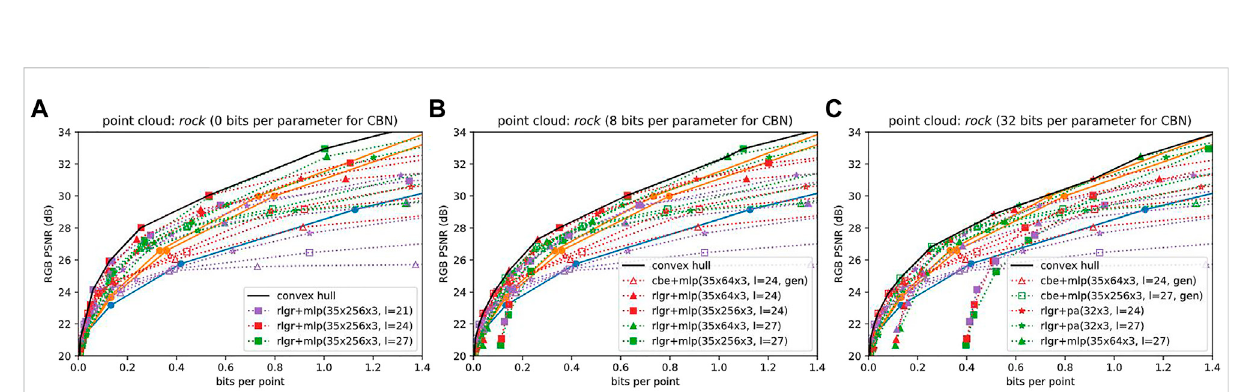
FIGURE 12 Convex hull (solid black line) of RD performances of all CBN con fi gurations across all levels, including side information using 0 (A) , 8 (B) , and 32 (C) bits per CBN parameter. Con fi gurations that participate in the convex hull are listed, with baselines, in the legend and appear as solid lines. Others are dotted. At 0 bits per parameter (bpp), the more complex CBNs dominate. At higher bpp, the less complex CBNs begin to participate, especially at lower bit rates. CBNs generalized from another point cloud never